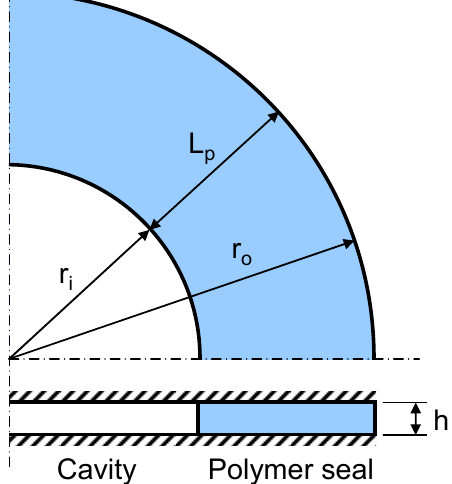
Figure 3. Schematic diagram of the geometry of 1-D axisymmetric case (the top and bottom surfaces are